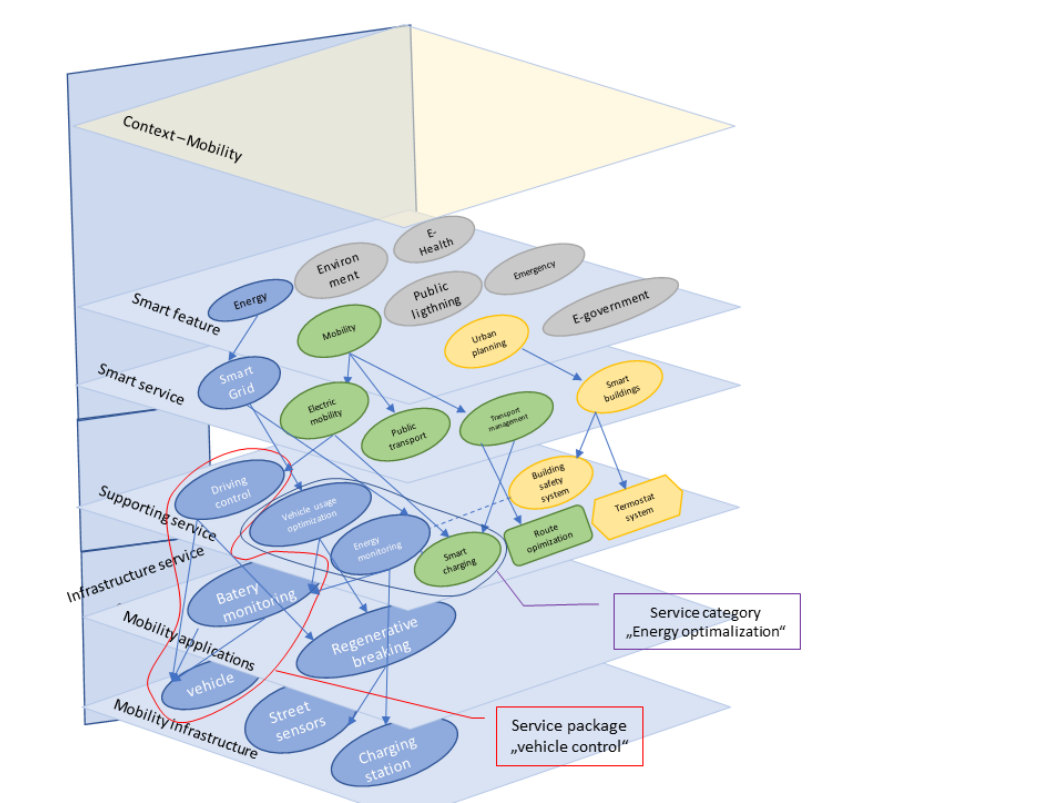
Figure 7. Service package and Service category